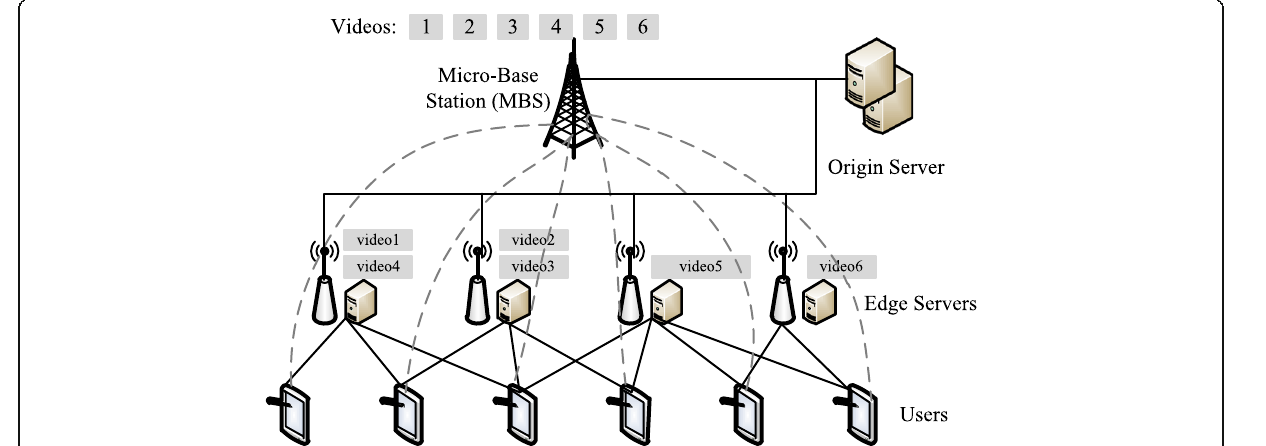
Fig. 3 Multi-rate video cache